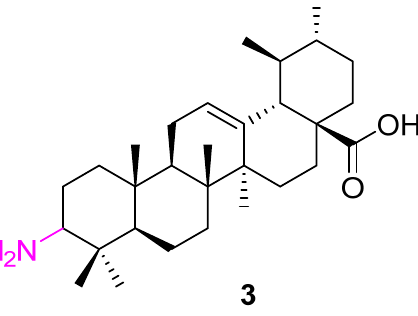
Figure 4. Structure of 3 .